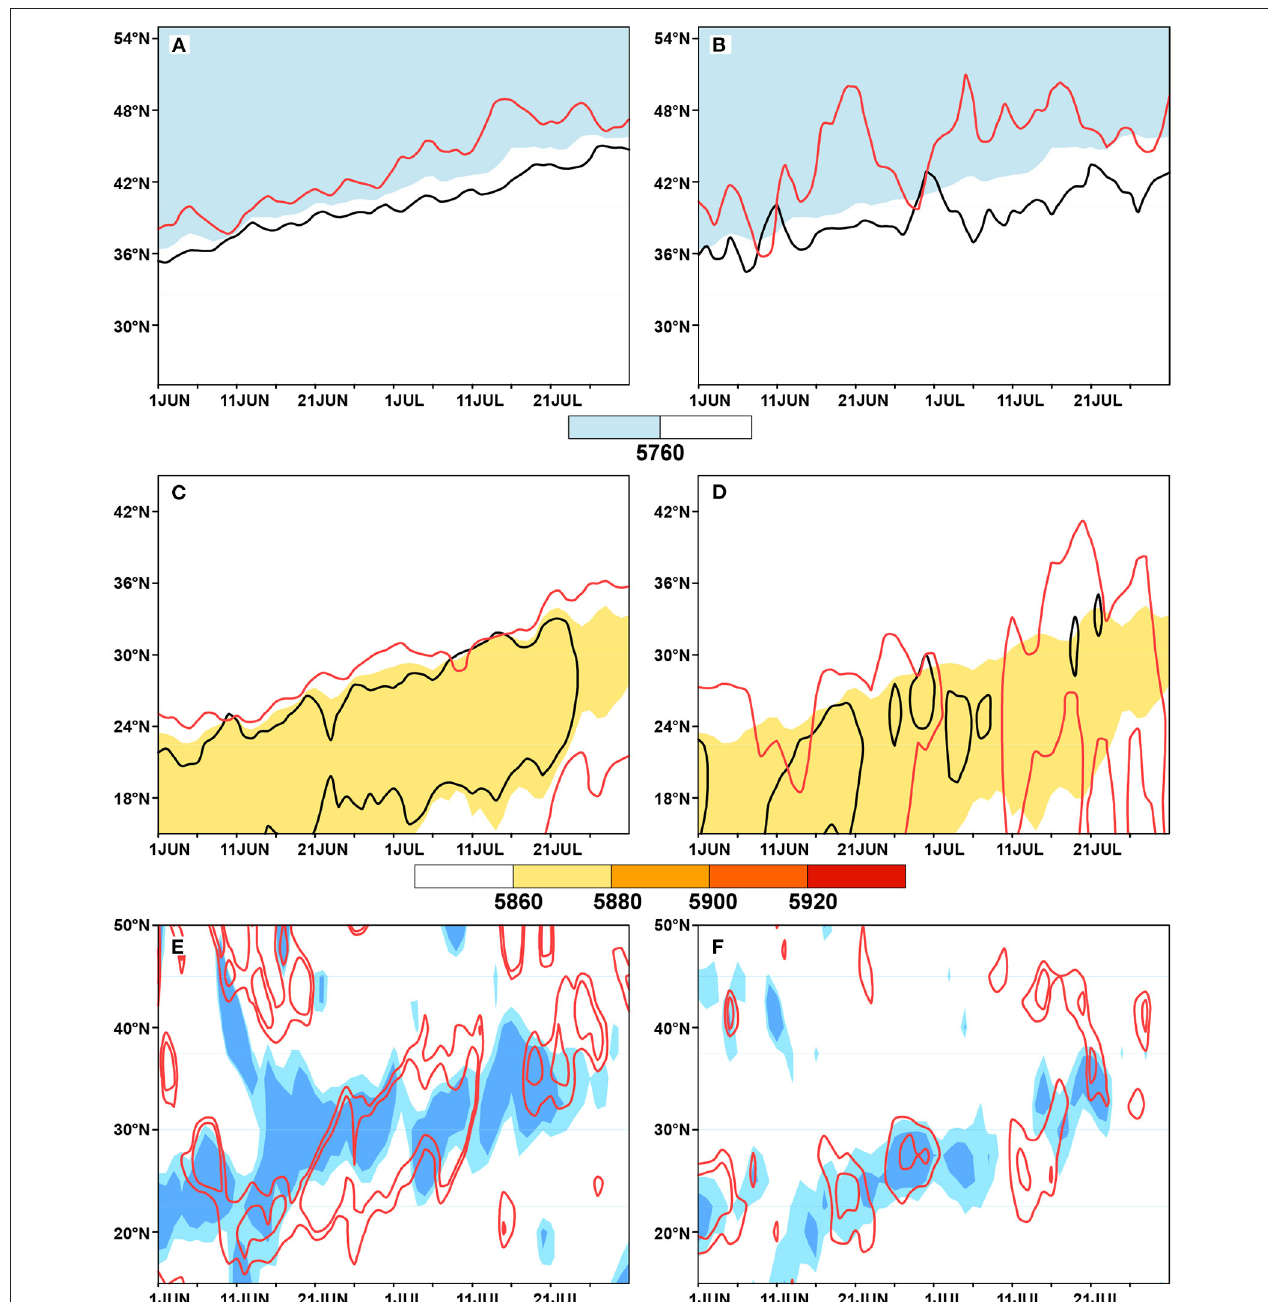
FIGURE 4 | Time–latitude profiles of (A,B) geopotential height at 500 hPa averaged over 100–120 ◦ E (units: gmp; shading for geopotential height lower than 5,760 gpm, red and black lines for warm and cold period, respectively) and (C,D) geopotential height at 500 hPa averaged over 110–130 ◦ E (units: m s − 1 ; shading for geopotential height higher than 5,860 gpm, red and black lines for extreme years of warm and cold periods, respectively) and (E,F) vorticity averaged over 110–130 ◦ E (units: 10 − 6 s − 2 ; shading for vorticity > 10 − 5 s − 2 for the cold period, red contour for the warm period). The left panel shows annual mean variables, and the right panel shows extremely warm years averaged variables [ (A,C,E) are average for warm and cold periods; (B,D,F) are average for extremely warm years of warm and cold period].